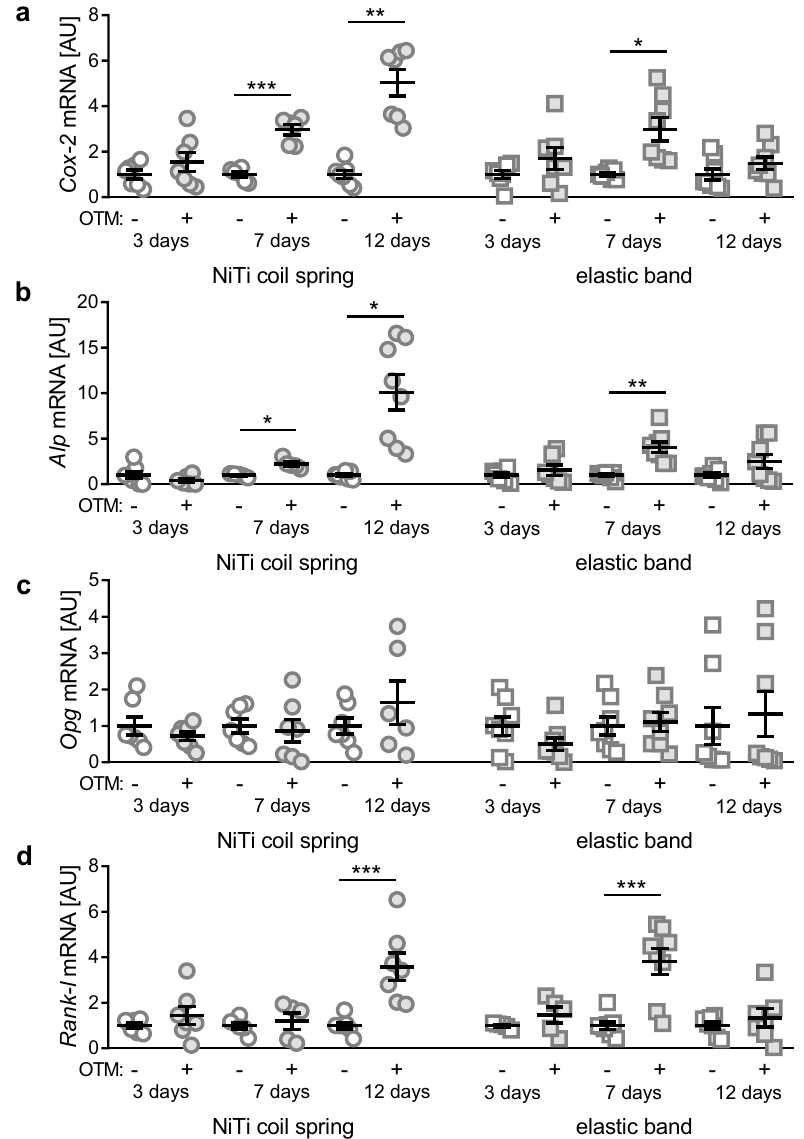
Figure 2. Relative Cox-2 ( a ), Alp ( b ), Opg ( c ) and Rank-l ( d ) gene expression after three, seven or 12 days of OTM with a NiTi coil spring or an elastic band compared to the untreated contralateral jaw side.[AU] arbitrary units. * p ≤ 0.05, ** p ≤ 0.01, *** p ≤